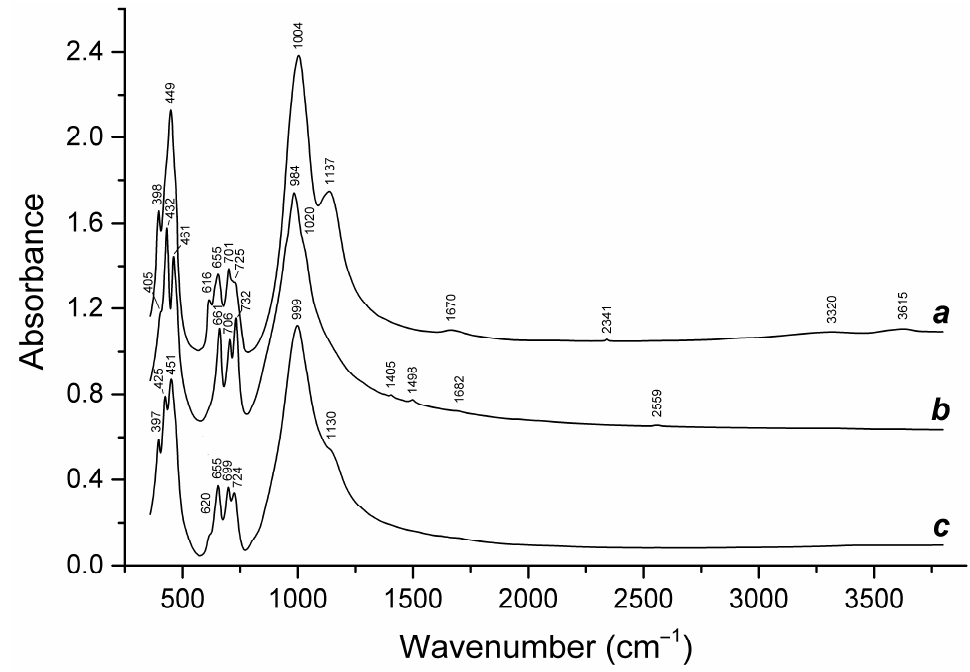
Figure 7 . Infrared spectra of ( a ) initial haüyne (Sample 5), ( b ) Sample 5 preheated for three days at 700 ◦ C over the Fe-FeS buffer, and ( c ) preheated Sample 5 additionally annealed at 800 ◦ C in air for one day.